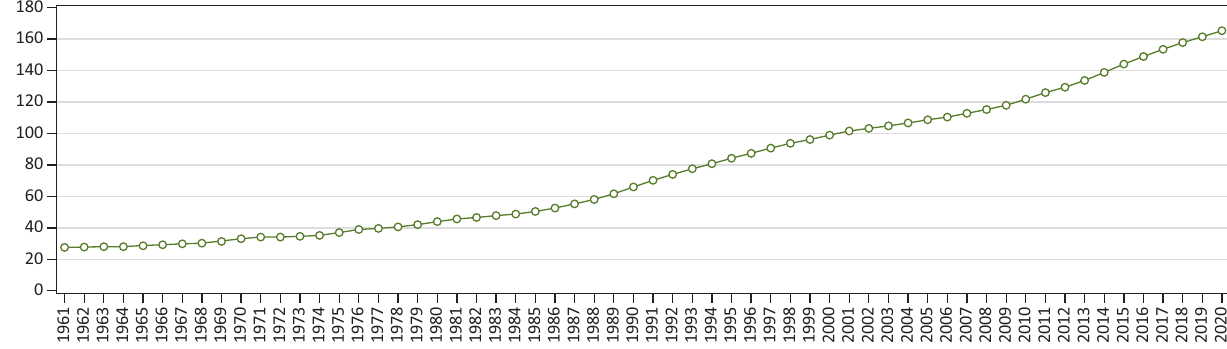
Figure 10. Ageing index per year (ratio %). Source: PORDATA and Fundação Francisco Manuel dos Santos (2021). Urban Planning, 2022, Volume 7, Issue 1, Pages